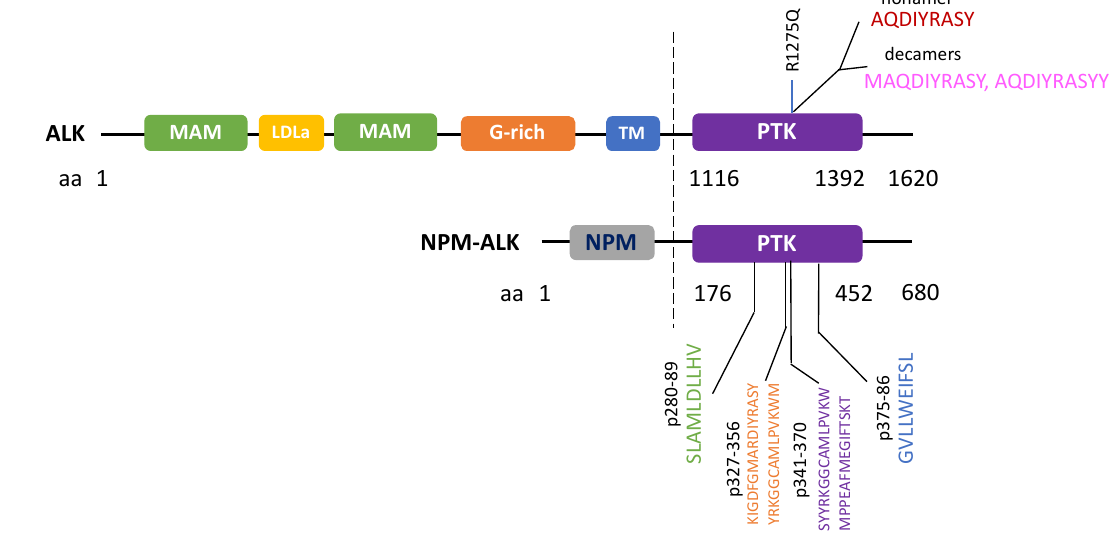
Figure 3. ALK Immunogenic peptides known to trigger cytotoxic T-cell responses.